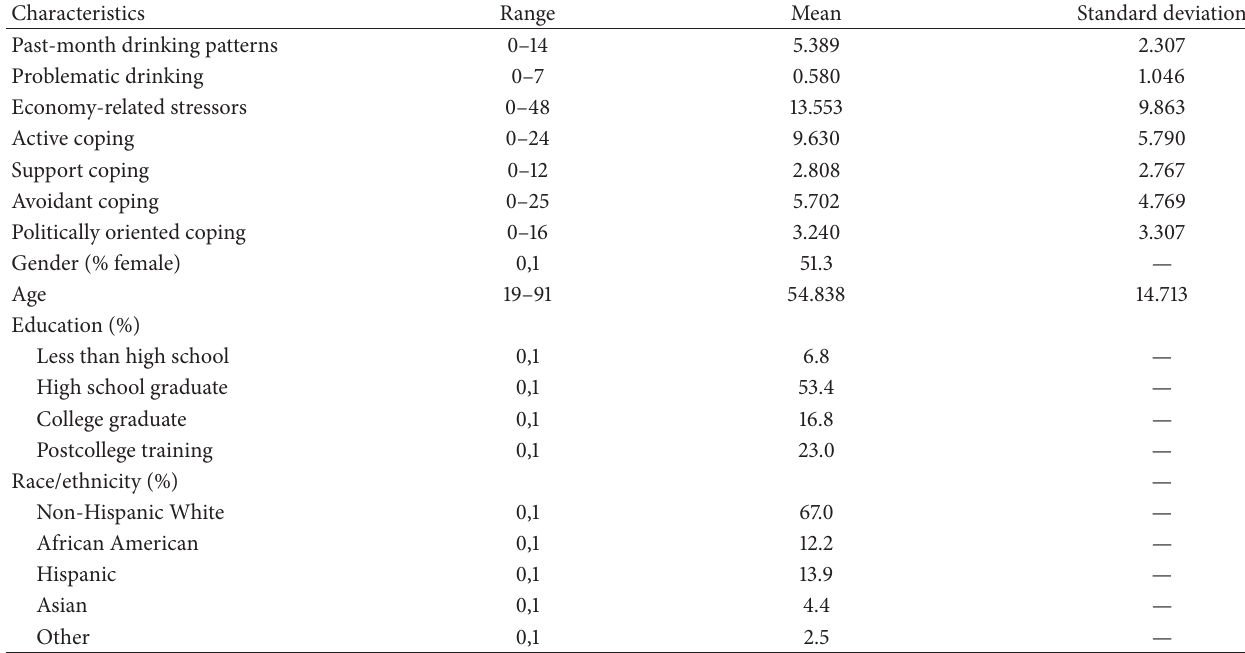
Table 1: Characteristics of study variables ( 𝑁 = 663